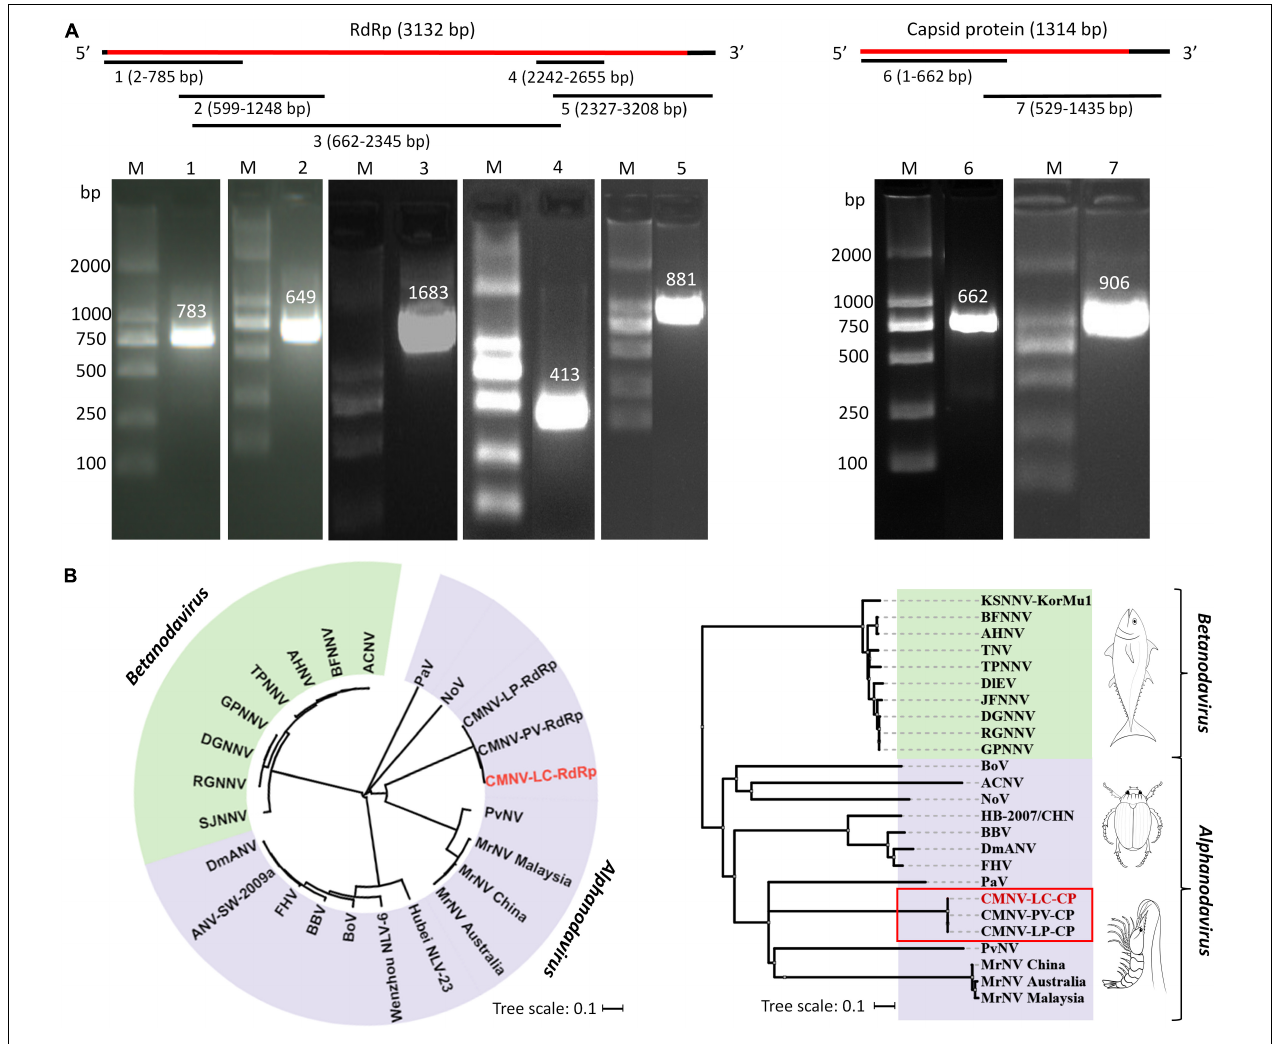
FIGURE 4 | The cloning and sequences analysis of RdRp gene and capsid protein gene of CMNV isolated from Larimichthys crocea . (A) Assembly strategy and agarose gel electrophoresis of PCR amplicons in cloning RdRp and capsid protein genes from L. crocea . The numbers 1–7 represent the seven PCR amplicons produced in cloning the CMNV genome. The images are cropped from the original image ( Supplementary Figure 4 ). Lane M: 2000 bp marker; lanes 1–5: amplicons of the sequence of RdRp; lanes 6 and 7: amplicons of the sequence of capsid protein. (B) Phylogenetic diversity of RNA-dependent RNA polymerase (RdRp) and capsid protein genes from different CMNV isolates and other nodaviruses (for virus abbreviations, see Supplementary Table 1 ). CMNV-LC-RdRp and CMNV-LC-CP represented the RdRp and capsid protein gene of CMNV isolated from L. crocea , respectively. The phylogenetic tree was generated by the neighbor-joining method using the MEGA 7.0 program, and the scale bar was